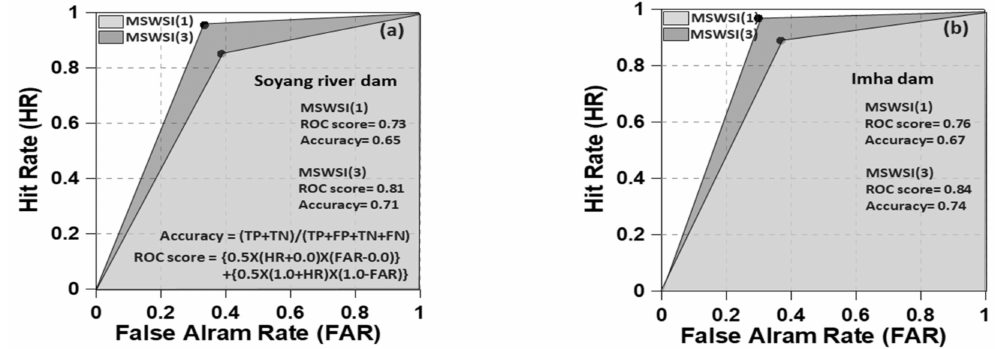
Figure 4. Receiver operating characteristic (ROC) diagrams of MSWSI(1) and MSWSI(3) for two dam basins. Results of ROC analysis for the Soyang river dam ( a ) and Imha dam ( b